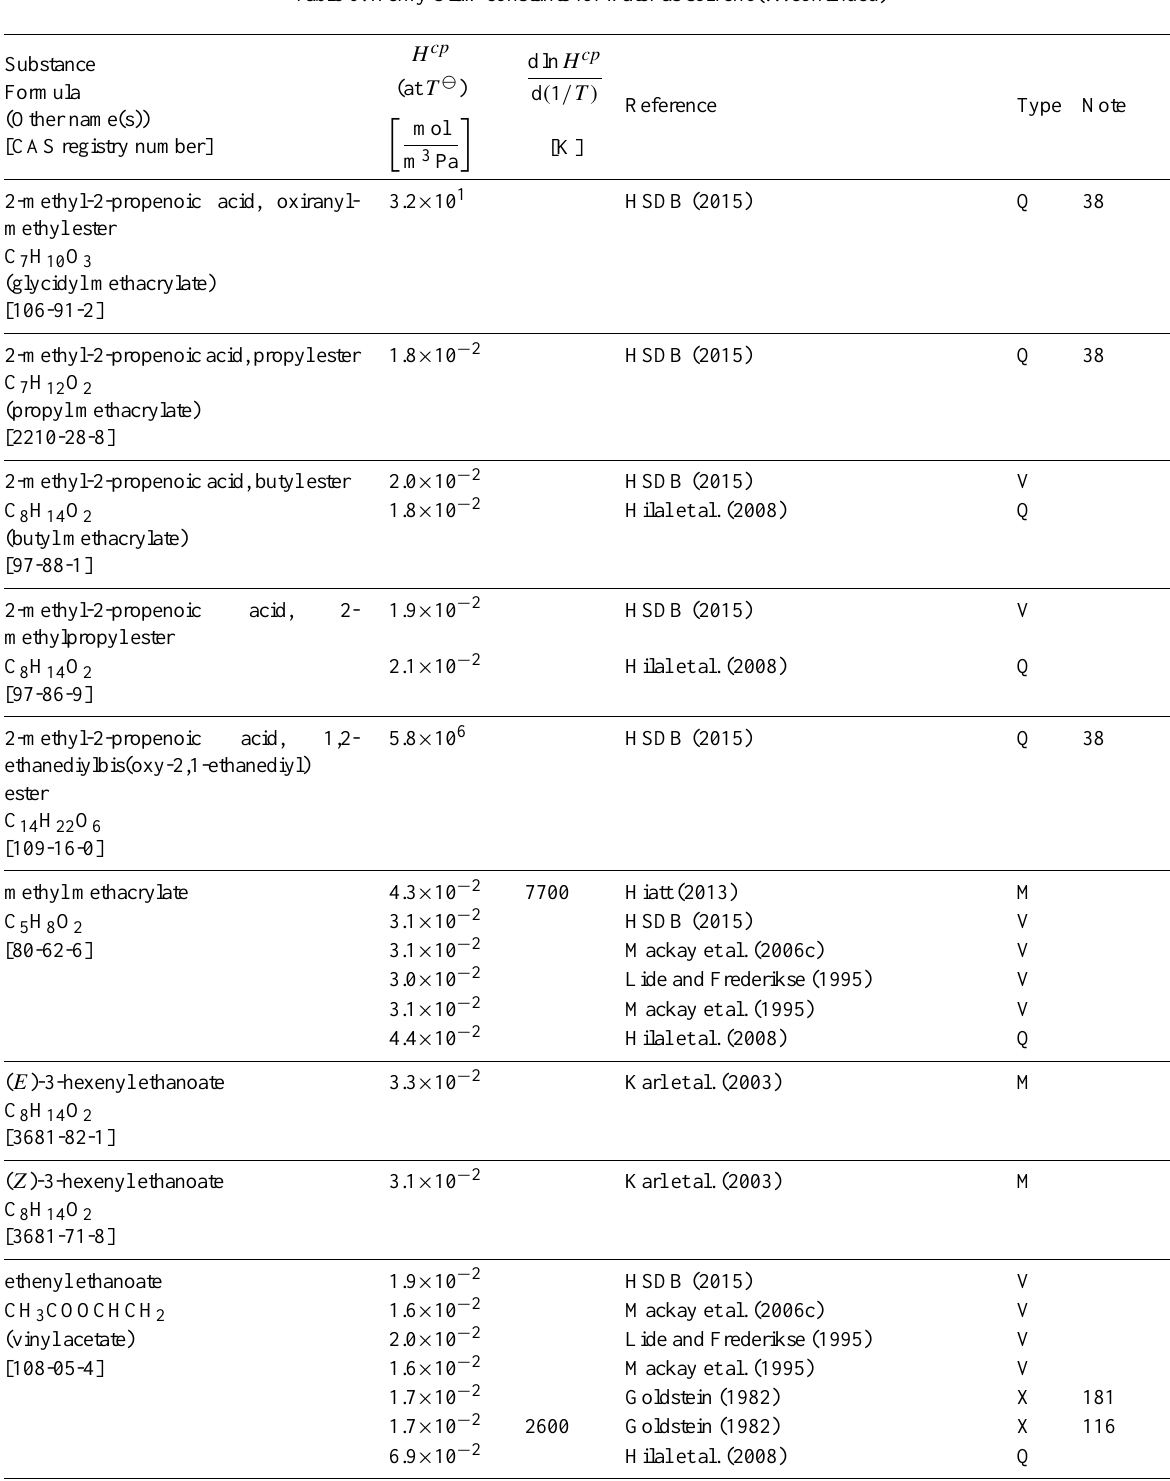
Table 6: Henry’s law constants for water as solvent